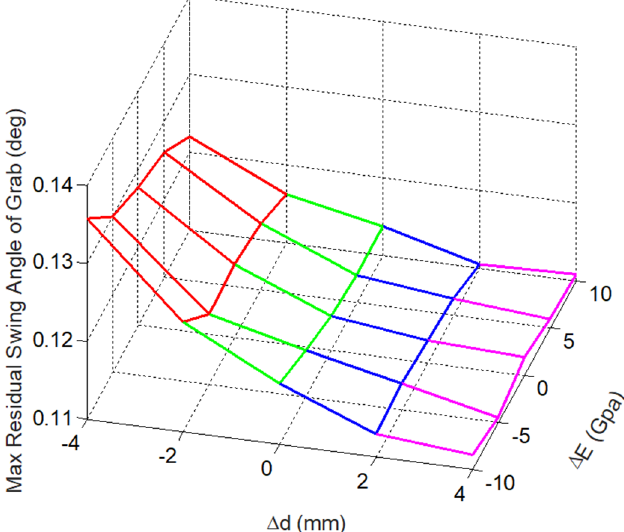
Fig. 10. Curves of maximum residual swing angle varied with the deviations of the wire rope diameter and the elastic modulus during full load process.